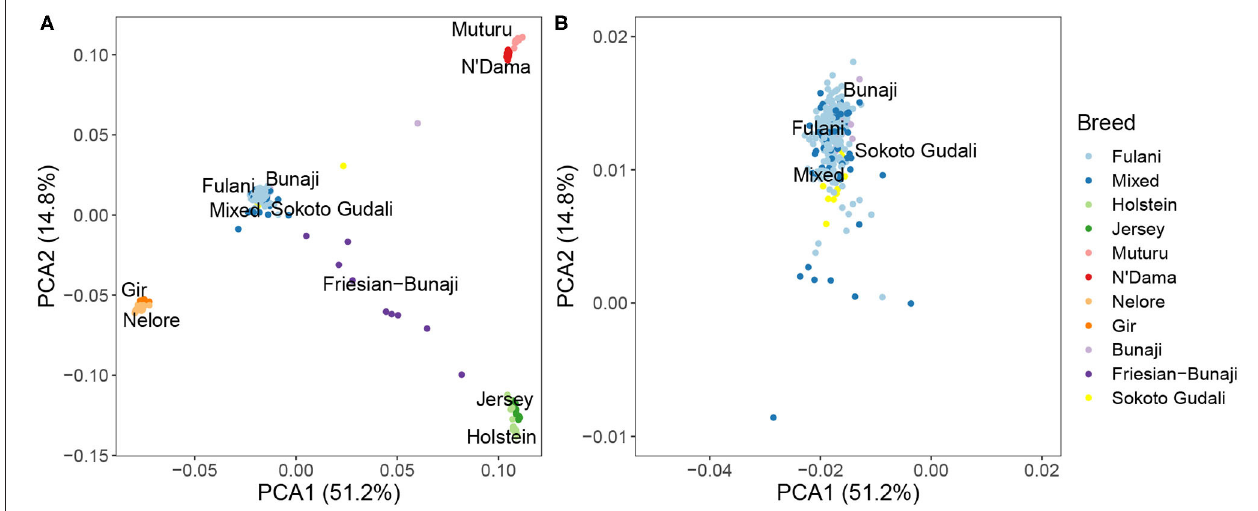
FIGURE 2 | (A) PCA plot for the Fulani and mixed breeds with the reference cattle breeds for the first two principal components. (B) Zoomed in PCA plot showing the Fulani and mixed